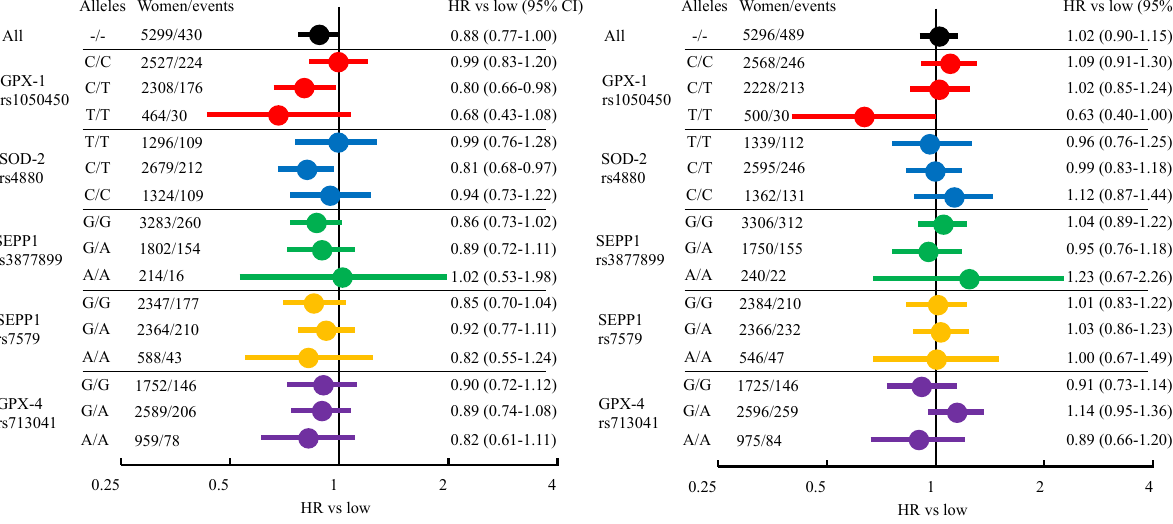
Figure 3. Forest plot of age adjusted hazard ratios (HR) for selenium intake tertiles and breast cancer risk. Each color represent results stratified for different SNPs.